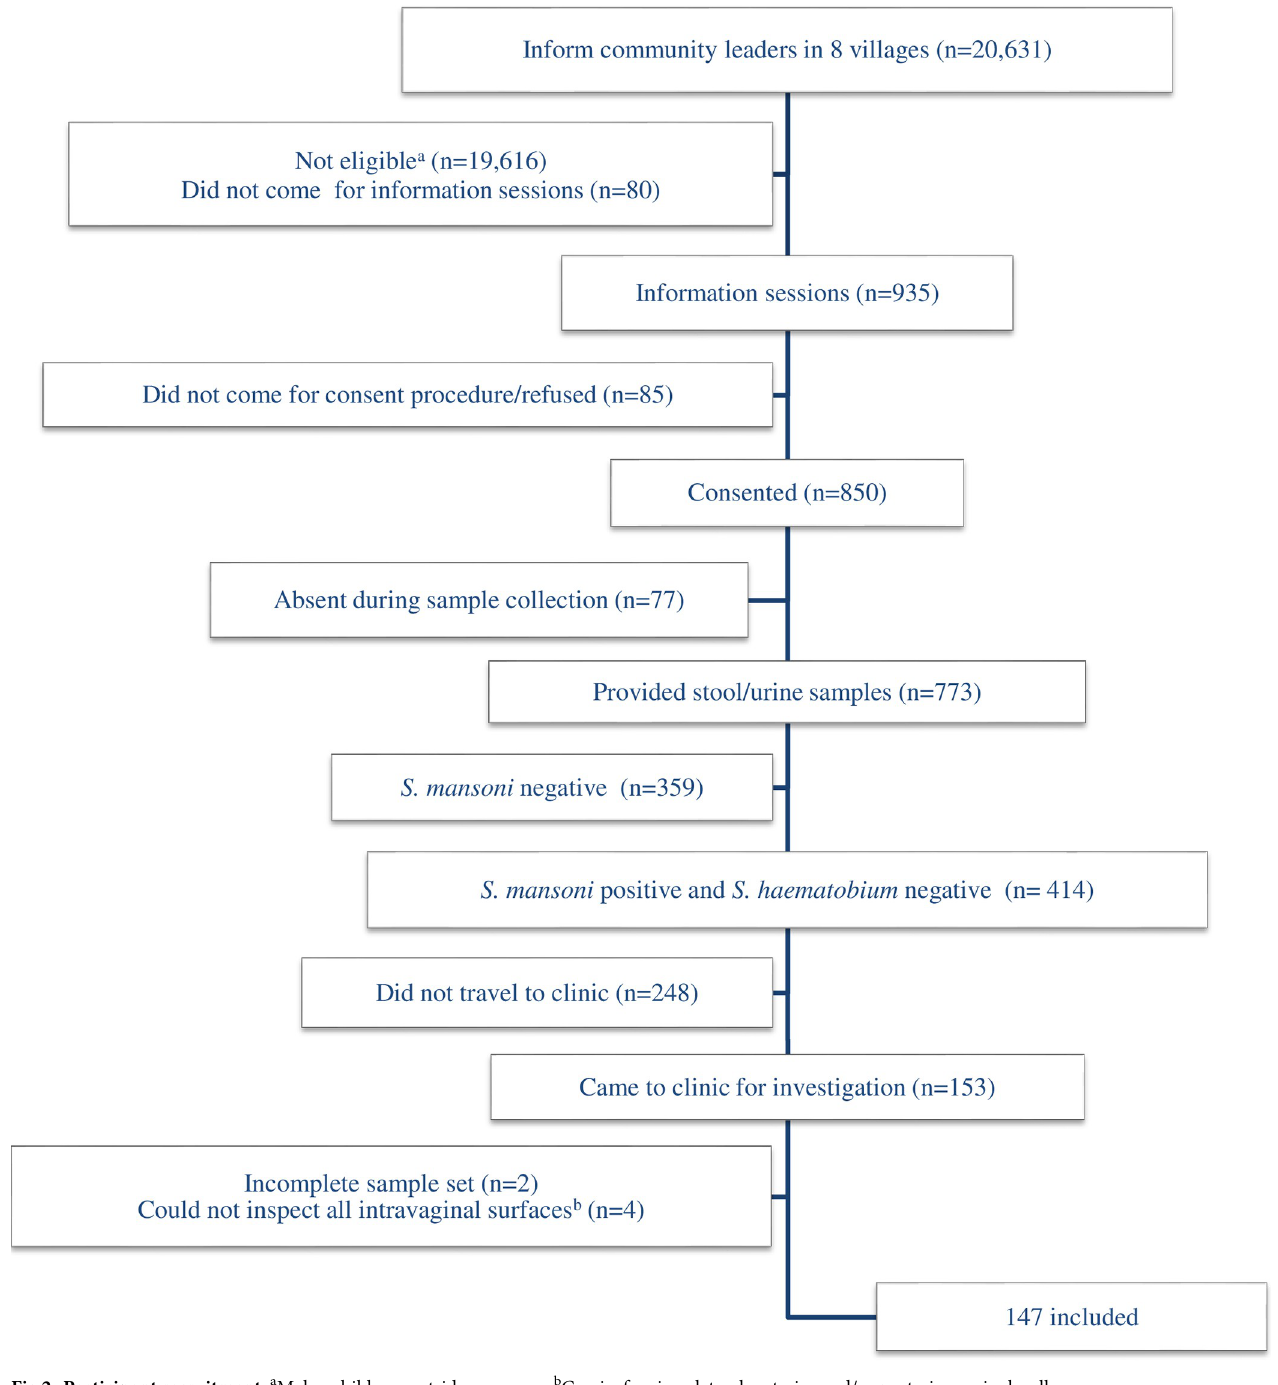
Fig 2. Participant recruitment. a Males, children, outside age range. b Cervix, fornices, lateral, anterior and/or posterior vaginal walls.